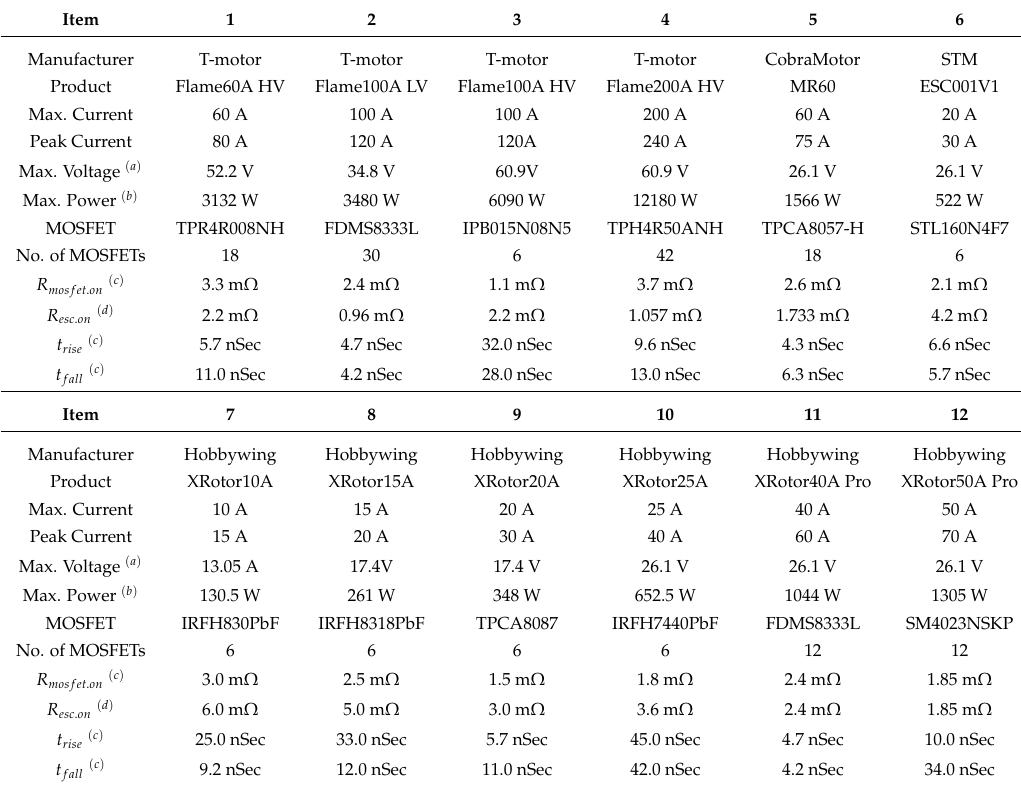
Table 3. Commercial multicopter dedicated ESCs and metal oxide semiconductor field-effect transistors (MOSFETs) specification